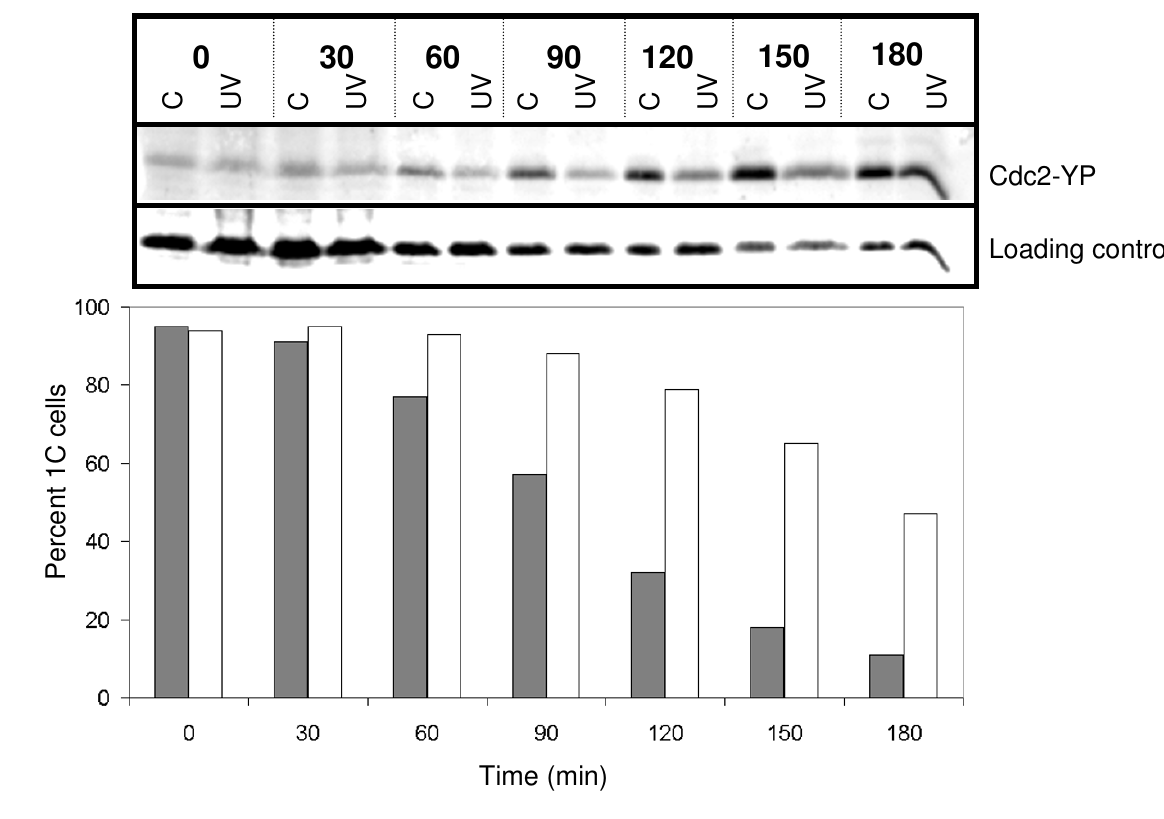
to Figure 1A. Samples were taken for protein extracts and flow cytometry at the times indicated. Total protein extracts were prepared and the amount of phosphorylated Cdc2 was investigated by SDS-PAGE and immunoblot analyses against total Cdc2, which served as loading control, and phosphorylated Cdc2 (top panel). Quantification of the fraction of cells with a 1C DNA content is also shown in the bottom panel (filled symbols: control; open symbols: